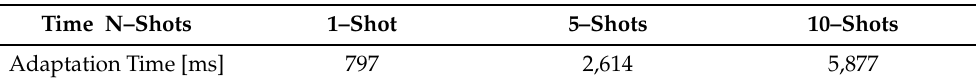
Figure 17. Standard prediction examples obtained post 1–shot test user-adaptation with MAML 2 nd . The top plots show the prediction ˆ x ∗ versus the respiration belt reference, while the bottom plots display the estimated bpm and corruption flag. Legends, which also apply to the plots on the right, are placed in the plots on the left. An example of optimal prediction with radar information characterized by little motion corruption is shown in ( a ). The respiration signal is recovered even in the presence of some corruption, as in ( b ), thanks to the L ∗ formulation. Table 3. MAML 2 nd experiments, average adaptation time over the last 300 episodes of test tasks T v evaluation, averaged over 3 repetitions using L ∗ , in